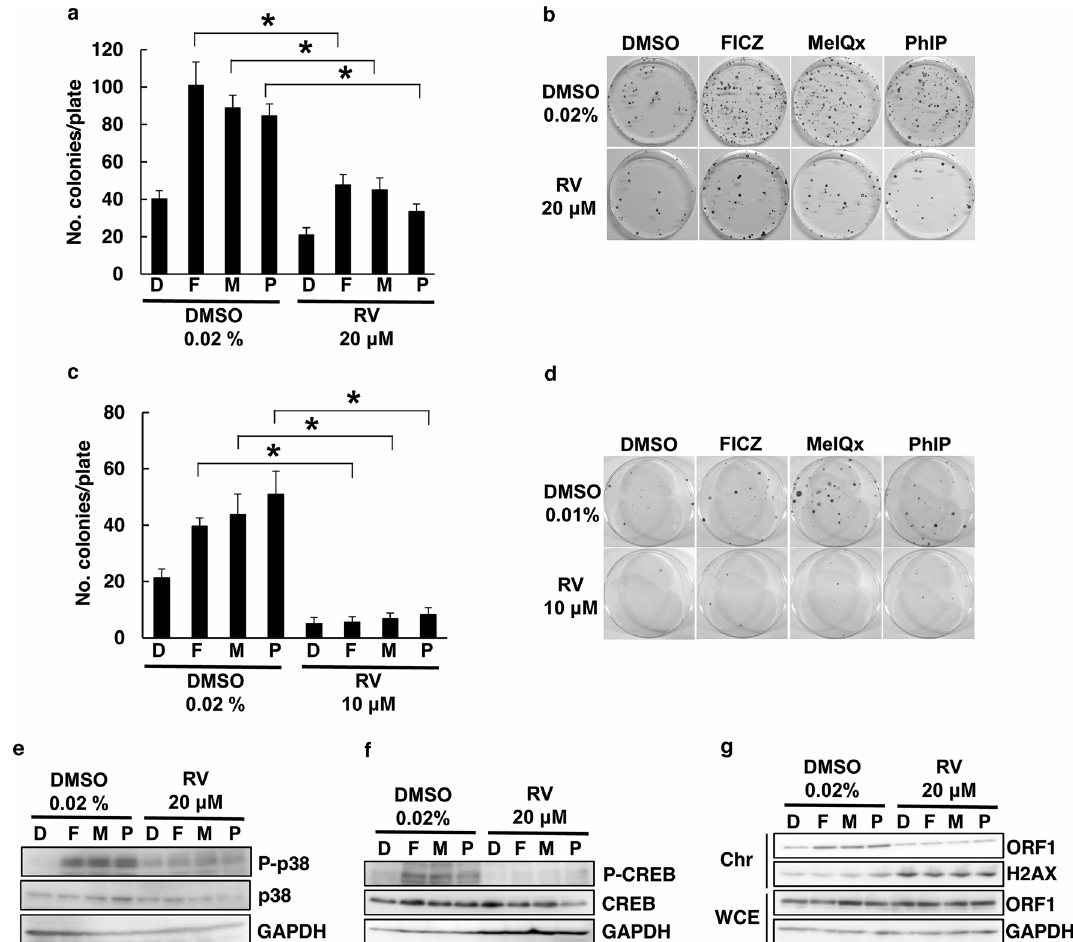
18 μM MeIQx (M), or 18 μM PhIP (P). (* p < 0.01). ( b ) Colony formation assay of the effects of RV. ( c , d ) Colony formation assay of the effects of RV on L1-RTP. The same experiments of panels A and B were done using HuH-7 cells. ( e , f ) RV inhibited phosphorylation of p38 and CREB induced by environmental compounds. RV was added at 20 μM to the culture medium 30 min before the addition of 10 nM FICZ (F), 18 μM MeIQx (M), or 18 μM PhIP (P) for 30 min. ( g ) RV blocked chromatin recruitment of ORF1. HeLa cells were first transfected with pORF1-TAP. After 48 h, cells were treated with either 0.02% DMSO (lanes 1–4) or 20 μM RV (lanes